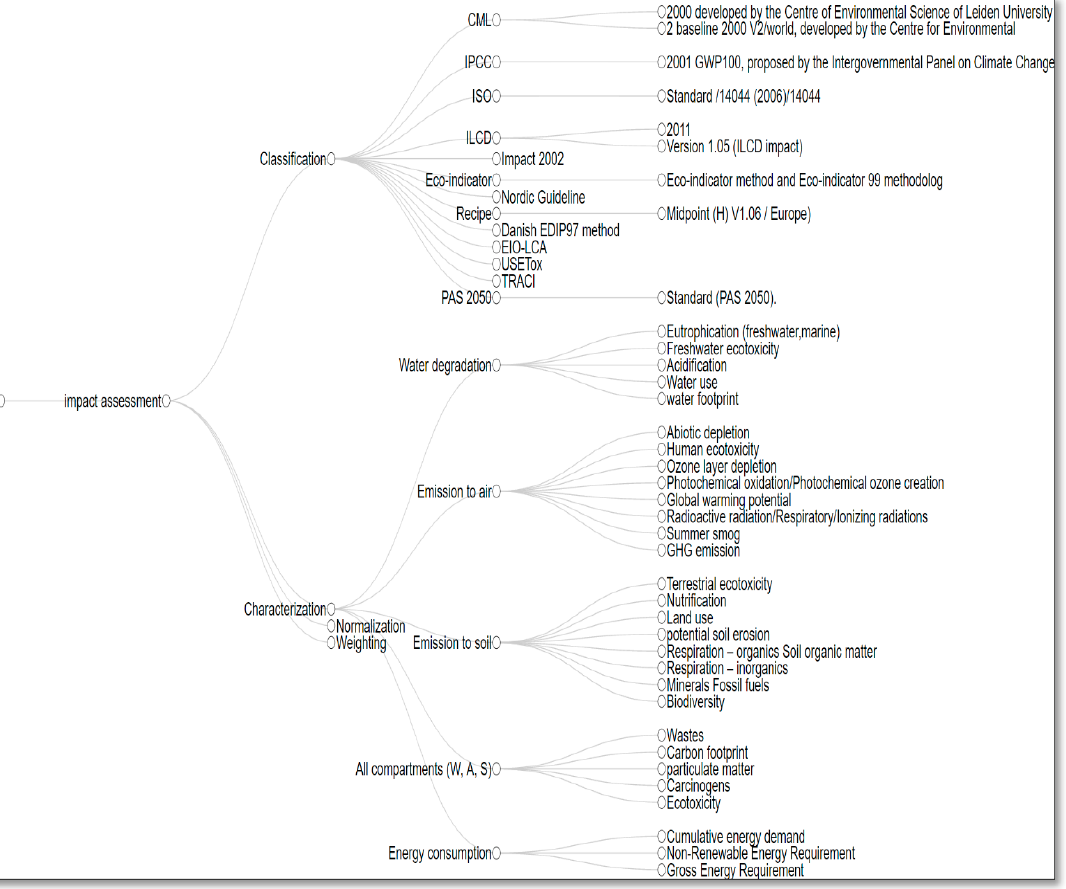
Figure 14. Quantitative and qualitative representation of the frequency of components of the LCIA phase in the reviewed studies.